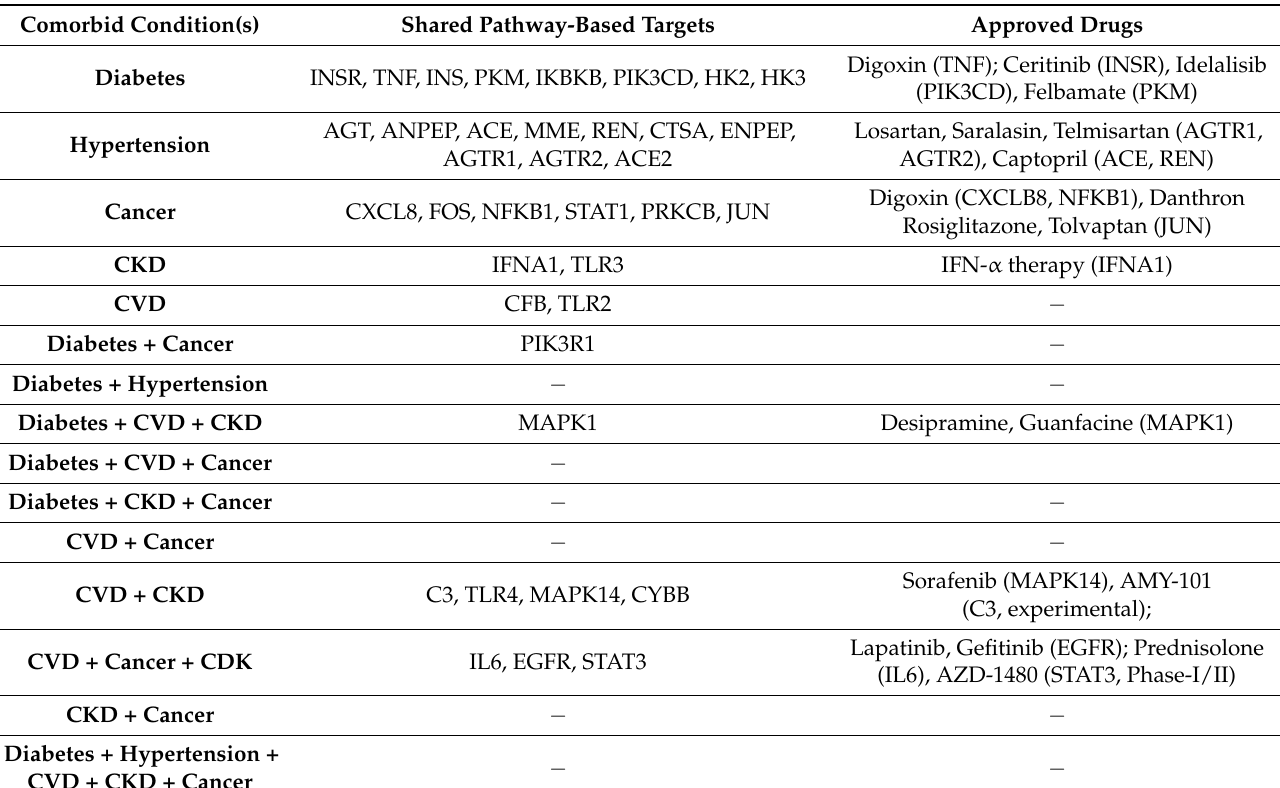
Table 2. Shared pathway-based targets (from top ten targets) and drugs for individual or combinations of comorbidity in COVID-19. Other drugs for these targets are presented in Figure S7.